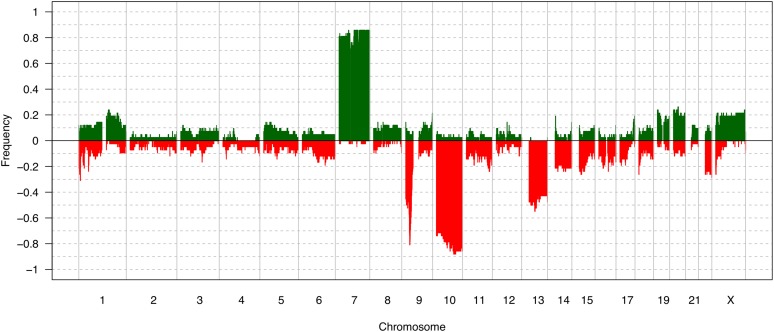
Frequency plot representing the gained and lost regions in glioblastomas.